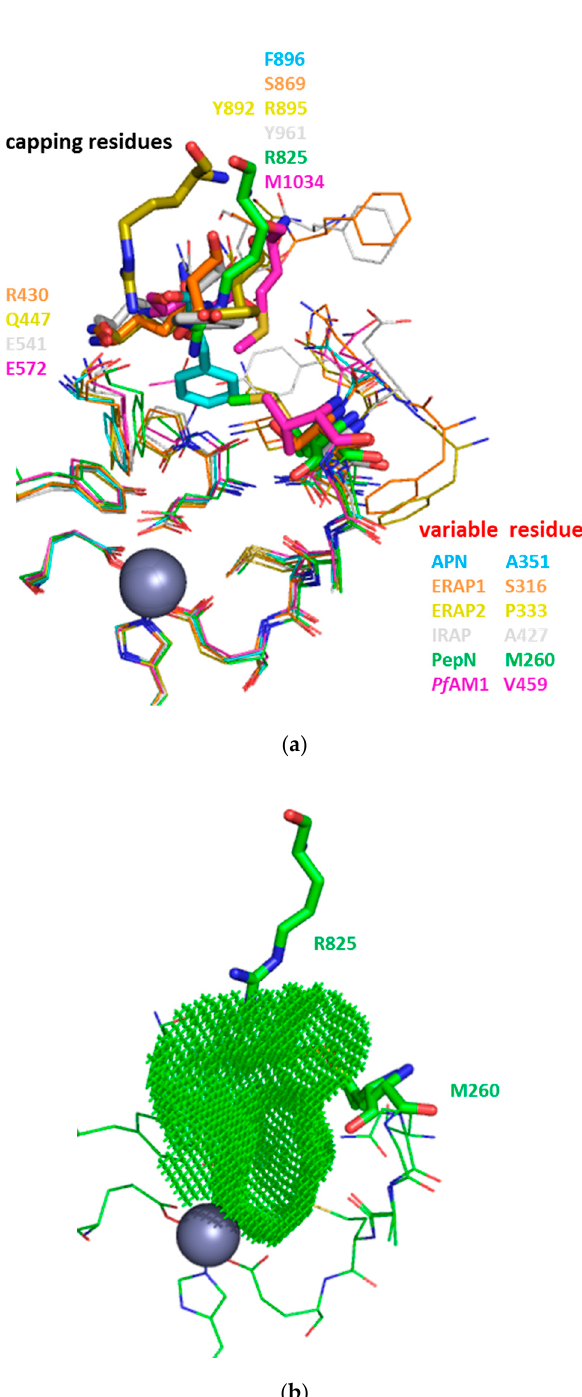
Figure 3. Diversity in the S1 subsite of different M1 aminopeptidases ( a ) Superimposition of the protein backbone of S1 subsite of different M1 APs: Hs APN (cyan, PDB 4FYT), Hs ERAP1 (orange, PDB 2YD0), Hs ERAP2 (yellow, PDB 4JBS), Hs IRAP (white, PDB 5MJ6), Ec PepN (green, PDB 5MFS), Pf AM1 (magenta, PDB 3EBH). ( b ) Surface representation of the S1 subsite of Ec PepN (PDB 5MFS). The catalytic zinc ion is shown as grey sphere. Residues involved in S1 plasticity are shown in stick. Images generated with KVFinder plugin in PyMOL.